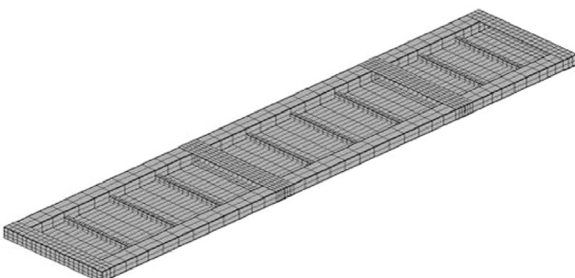
Figure 4: The model of the single